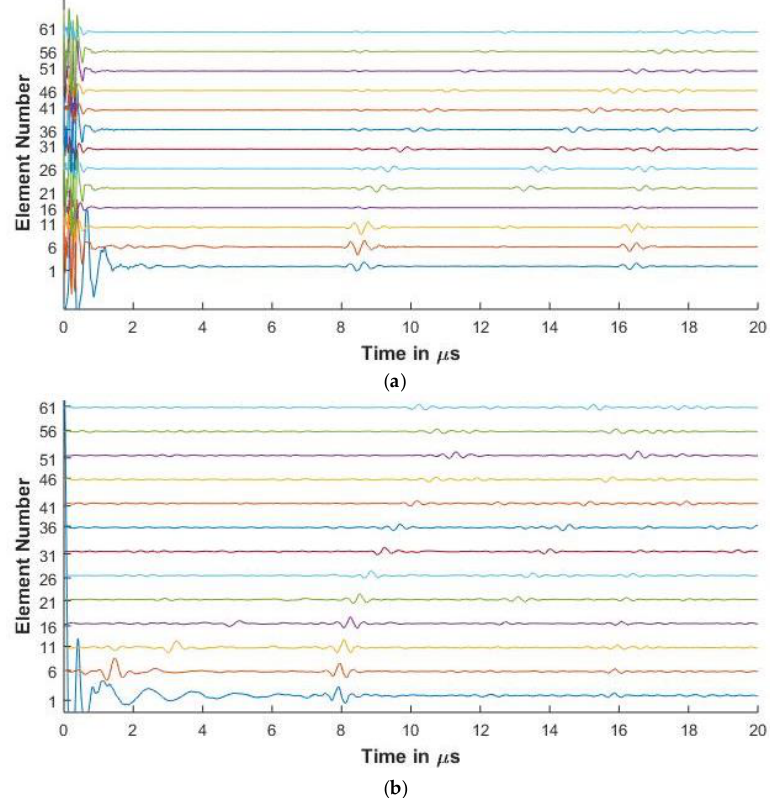
Figure 6. ( a ) Experimental full matrix capture (FMC) signals obtained for aluminium with 2.25 MHz 64 element array ( b ) Simulated FMC signals for aluminium with 2.25 MHz 64 element array.